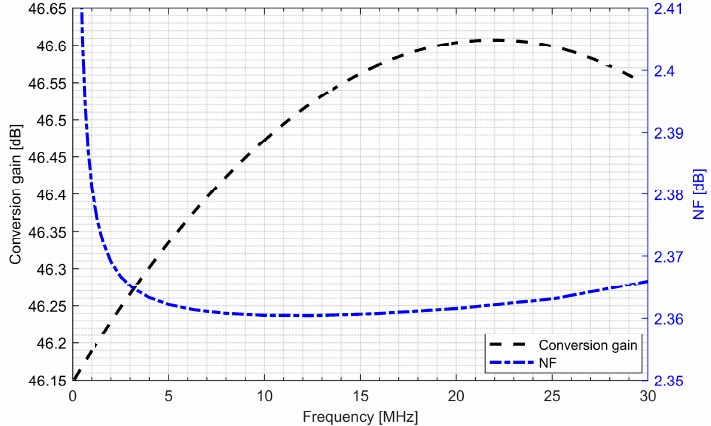
Figure 13. Conversion gain and noise figure of the L1/E1 radio-frequency front-end.